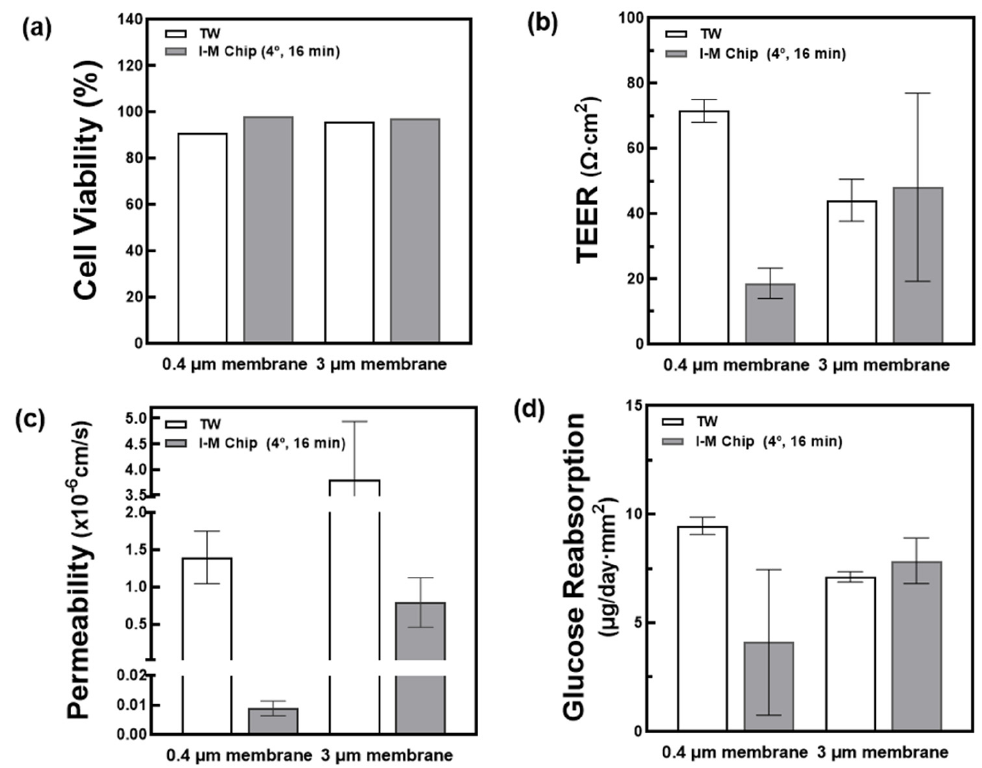
Figure 4. Confirmation of cell growth according to membrane size (0.4 µ m, 3 µ m). ( a ) Confirmation of cell viability through imageJ of images taken with L&D. ( b ) TEER measurement using a Millicell ERS-2 Voltohmmeter. ( c ) After 6 h of treatment with FITC–Dextran fluorescent dye at a concentration of 0.5 mg/mL, the transmittance was confirmed by measuring the absorbance (FL) of the fluorescence secreted above the membrane. ( d ) Glucose value of the medium 24 h after filling the TW and the chip with fresh medium was measured. Through this, the amount of glucose reabsorbed over 24 h was